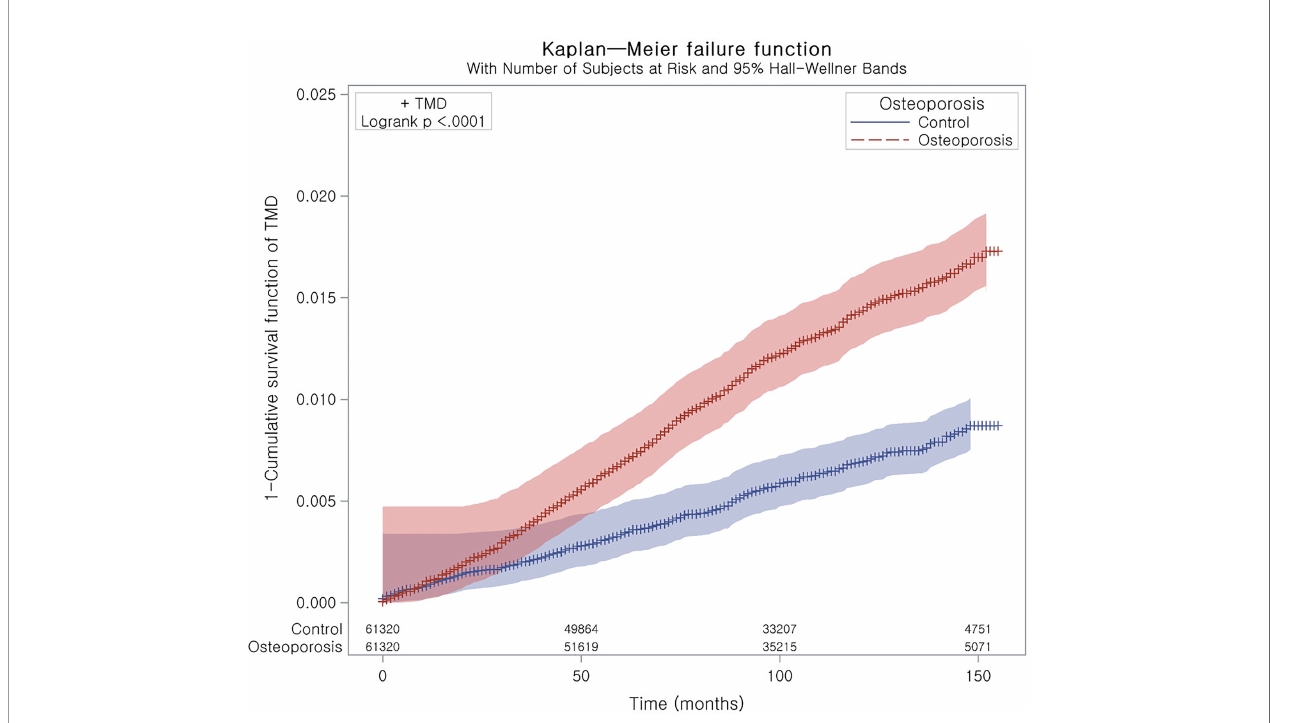
FIGURE 2 | Kaplan – Meier curve of TMD with osteoporosis. It represents a curve of 1 – survival